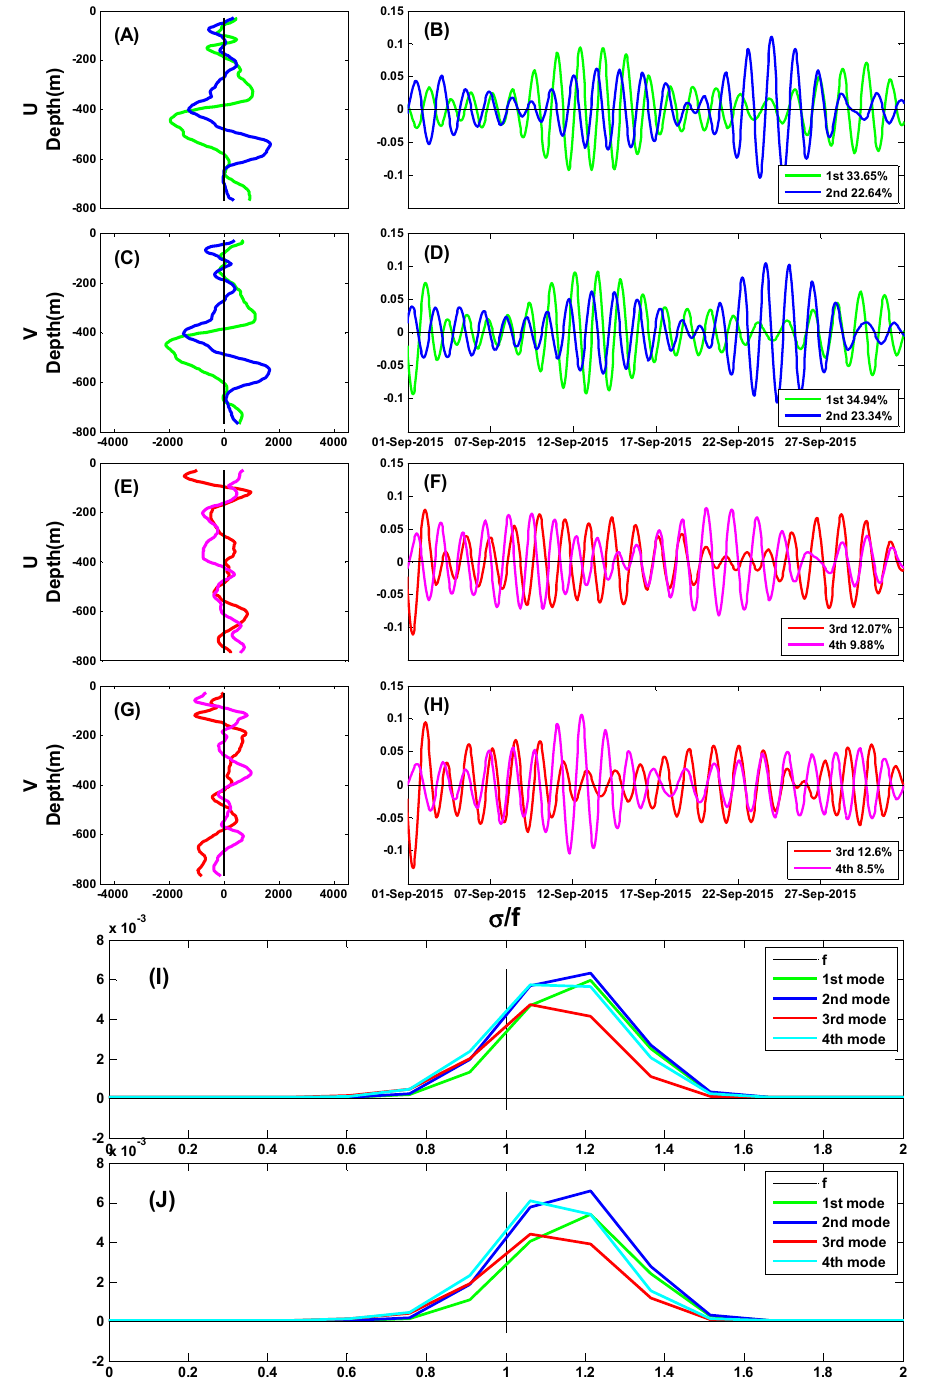
Figure 13. As for Figure 10 but the NIO signal occurred in September 2015.